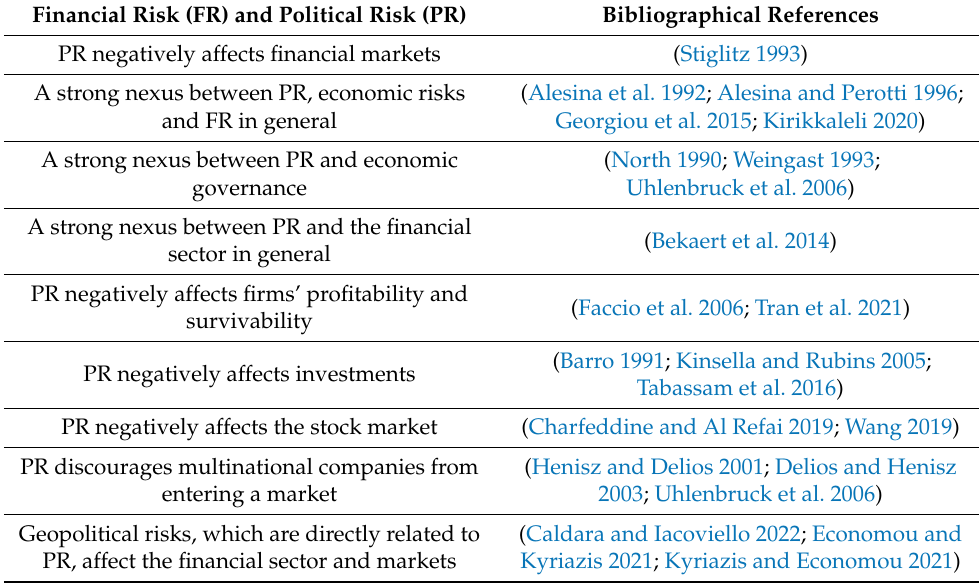
Table 1. The nexus between financial and sociopolitical